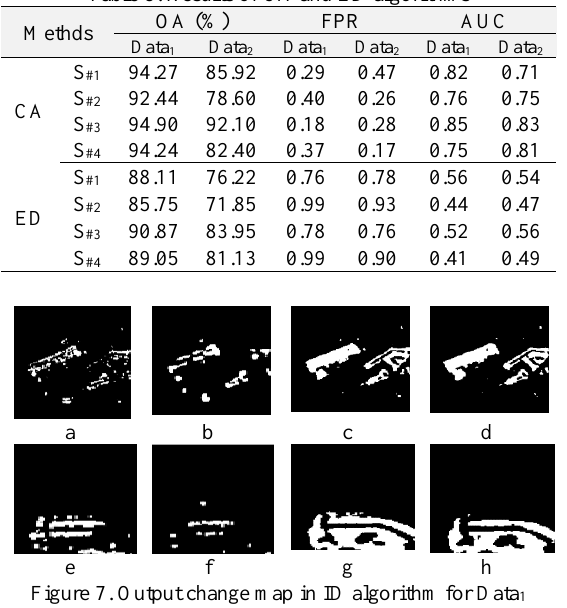
Figure 7. Output change map in ID algorithm for Data 1